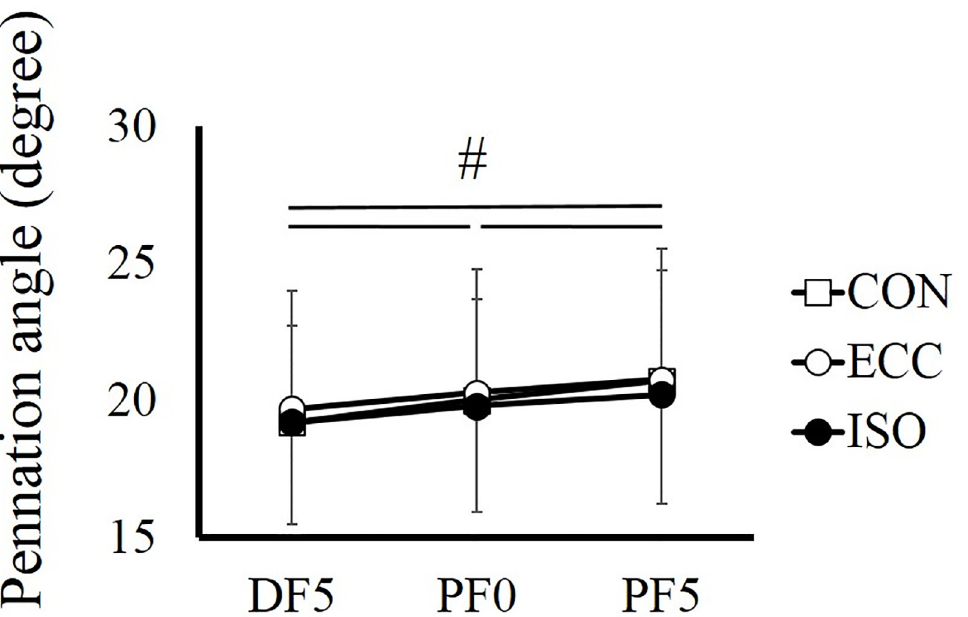
Fig 6. Pennation angle recorded at DF5°, PF0°, and PF5° in CON, ECC, and ISO conditions. # indicates a significant difference among joint angles ( P < 0.05). CON; concentric contraction without preliminary contraction, ECC; concentric contraction after preliminary eccentric contraction, ISO; concentric contraction after preliminary isometric contraction, DF; dorsiflexion, PF; plantarflexion.